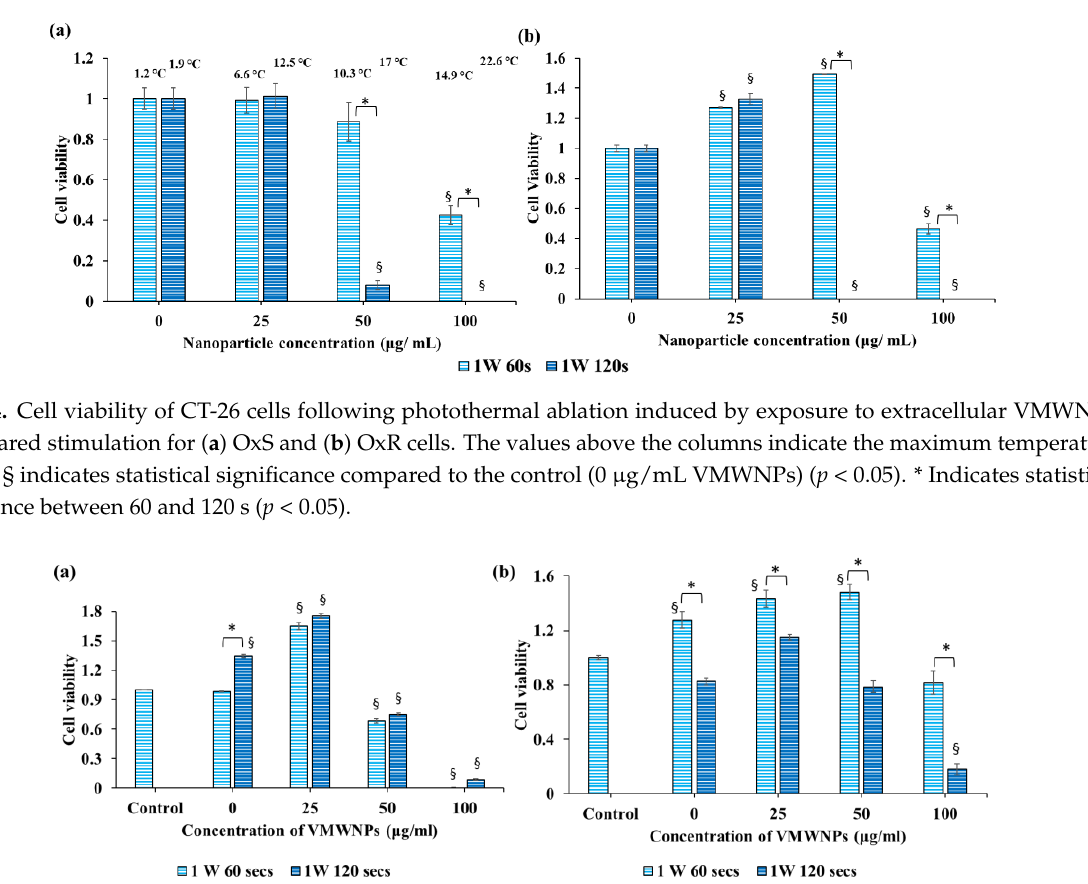
11 of 20 W) laser irradiation for 60 s or 120 s. With 60 s of laser exposure to the OxS CT-26 cells, there was no significant drop in cell viability up to 50 μg /mL, whereas a considerable reduction (52%) was noticed for 100 μg /mL (Figure 4a). Upon 120 s of laser stimulation, 50 μg /mL and 100 μg /mL produced almost 92% and complete ablation, respectively, whereas no effect was observed with the 25 μg /mL of VMWNPs (Figure 4a). For the OxR CT-26 cells, 60 s of laser stimulation resulted in no significant change in cell viability up to 50 μg /mL, but produced a 54% reduction in cell viability at 100 μg /mL (Figure 4b). Two minutes of laser irradiation produced complete ablation with the 50 and 100 μg /mL of VMWNPs, but there was no difference at 25 µg/mL (Figure 4b). For OxS RKO cells, a 68% decrease in cell viability was observed with 50 μg /mL and complete ablation with 100 μg /mL (Figure 5a), with similar results for 60 or 120 s exposure. OxS RKO cells had an increase in cell viability with 60 or 120 s of 1 W laser stimulation with 0 and 25 µg/mL (Figure 5a). The same trend was observed in OxR RKO cells (Figure 5b). OxR RKO cells treated with 50 µg/mL and immediately exposed to 60 s of a 1 W laser had an increased viability, whereas 120 s led to a 22% reduction. OxR RKO cells treated with 100 µg/mL had 22% and 82% reductions for laser exposures of 60 s and 120 s, respectively. As shown in Figure 5a,b, control cells that were not exposed to the laser or VMWNPs were included